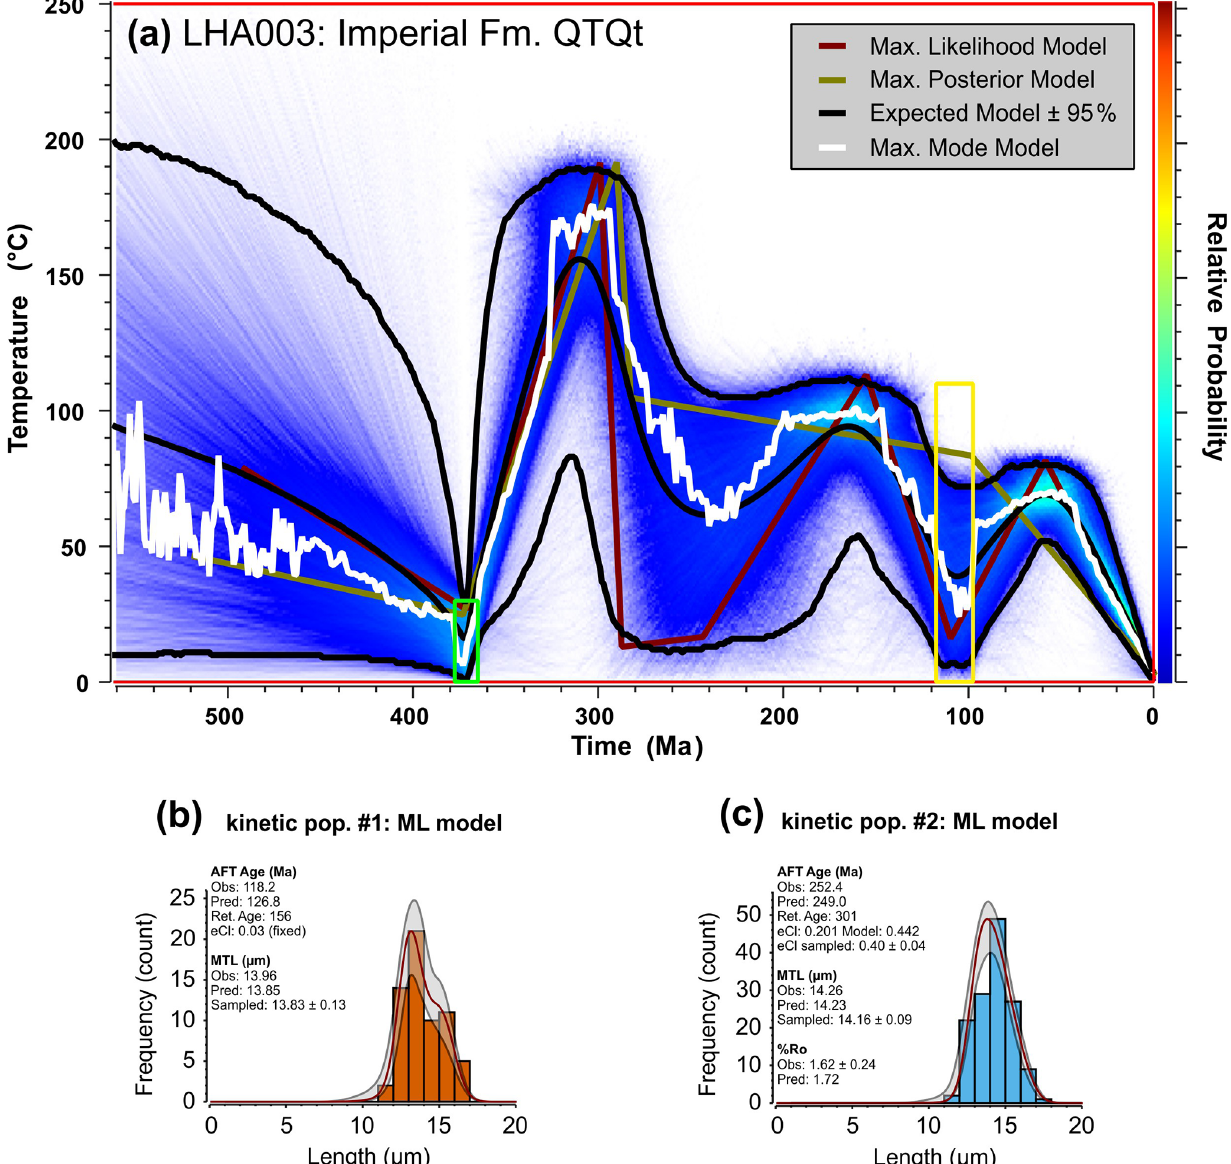
Figure 9. QTQt model results for Devonian detrital AFT sample LHA003 (Imperial Fm.). (a) Time–temperature plot of the histories retained post burn-in coloured according to relative probability, with warmer colours denoting higher probability. Individual model descriptions are the same as those in Fig. 8. (b) Maximum likelihood fit to the track length distribution and predictions for AFT age and MTL for population one using a fixed eCl value of 0.03apfu. (c) Maximum likelihood fit to the track length distribution and predictions for AFT age and MTL for population two, allowing for resampling of the calculated eCl value. Note that the MP model path differs from the ML model primarily because the large Cretaceous box allows a linear t – T segment between 280 and 100Ma that is simpler but provides a poorer fit to the data. The green box is the depositional age of 371 . 25 ± 6 . 25Ma (15 ± 15 ◦ C). The yellow box is the geologic constraint at 107 ± 10Ma (55 ± 55 ◦ C). The model setup is as follows: 500000 iterations (burn-in) and 500000 iterations (post burn-in; shown). The prior model space is 350 ± 350Ma and 125 ± 125 ◦ C. The modern surface temperature is 2 . 5 ± 2 . 5 ◦ C, and the maximum allowed ∂T/∂t is 20 ◦ CMyr − 1 . Proposal moves were rejected if proposed outside of the prior, and more complex models were rejected for equivalent